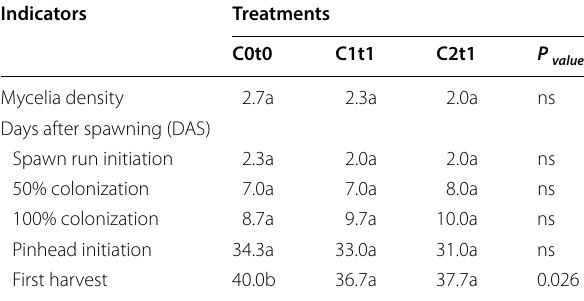
Table 3 Effect of nano-amino application on the first harvest